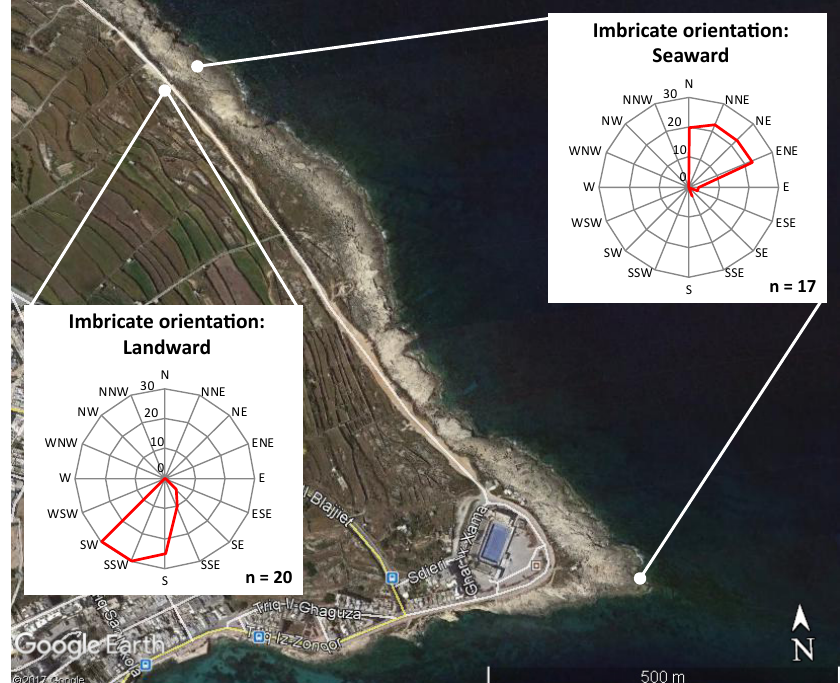
Figure 12. Rose diagrams illustrating contrasting directions of flow responsible for the deposition of boulders at two closely placed sites. The seaward site lies on the main boulder berm and shows that imbricated boulders there were emplaced by an onshore flow. In contrast the landward site at an elevation of 10–12 m asl indicates boulders there became imbricated as a result of a flow in the downshore direction.